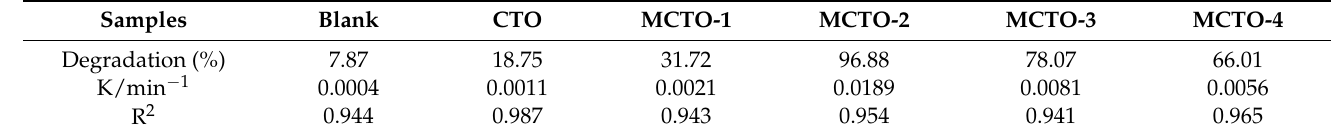
Table 2. First-order apparent rate constants (k) of different samples for RhB photodegradation. Samples